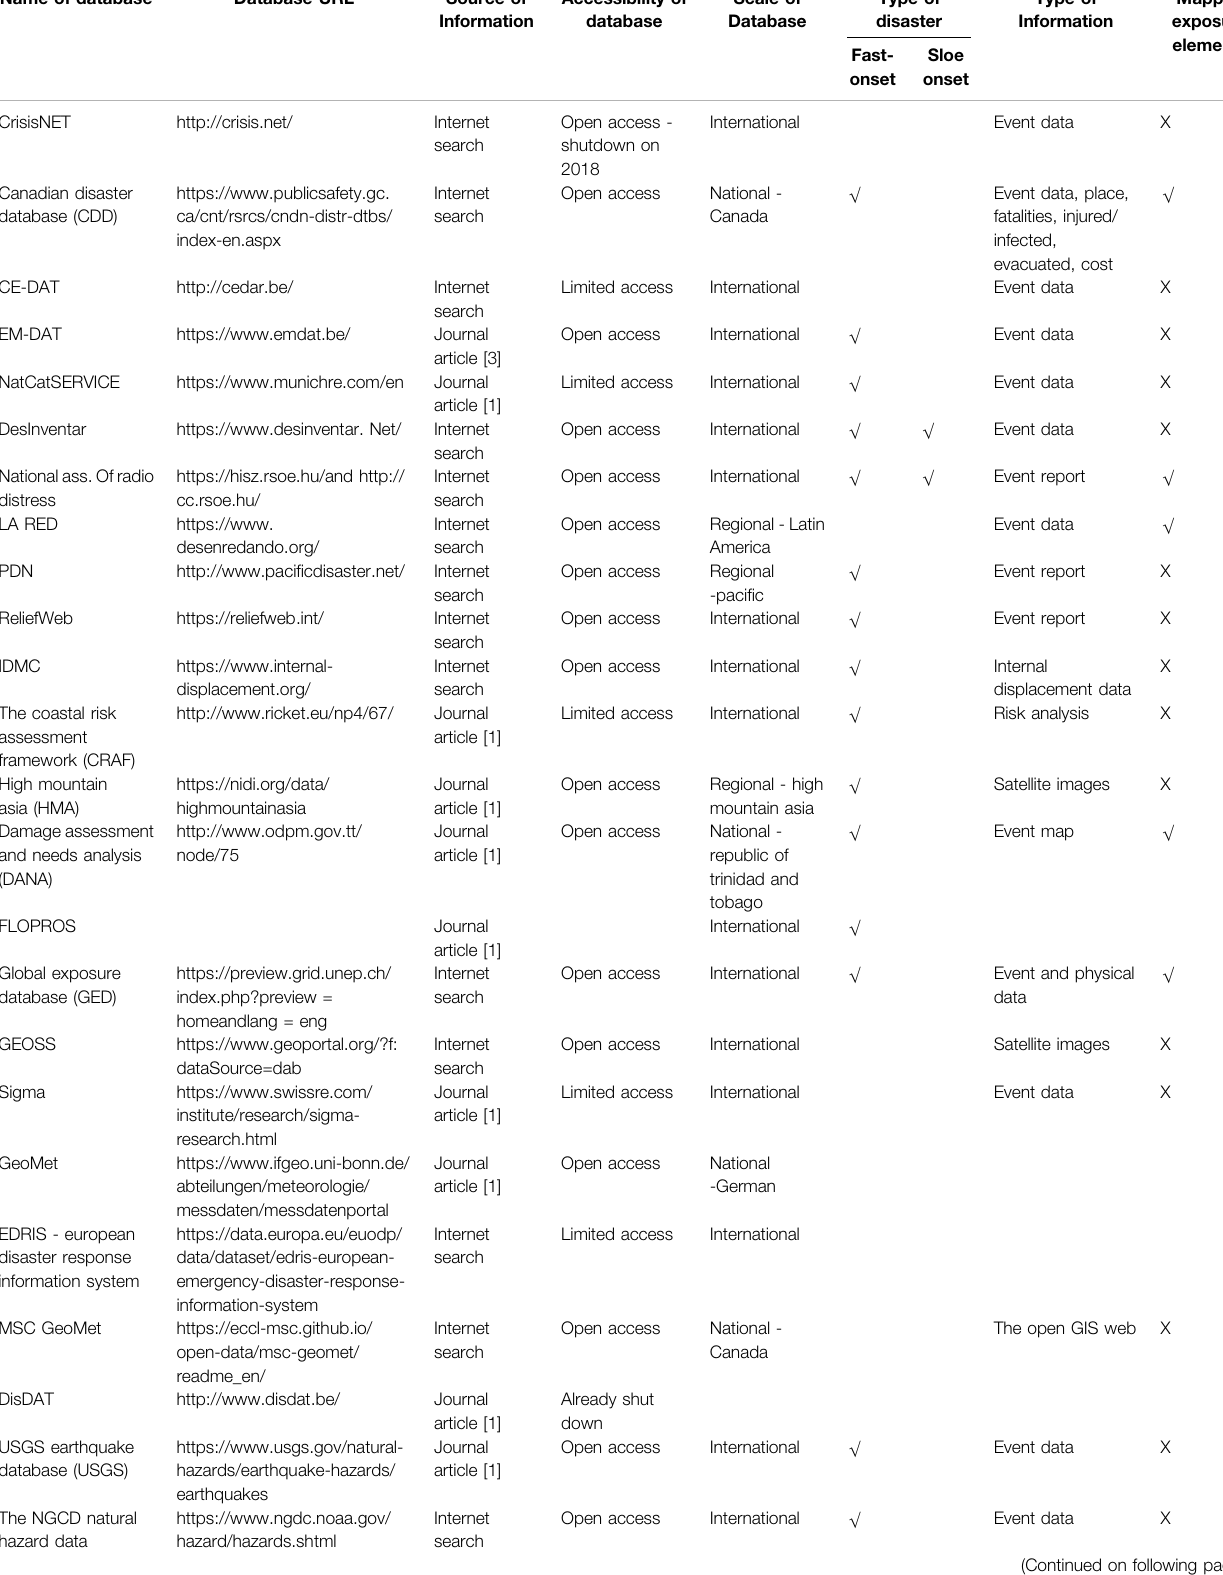
TABLE 2 | An overview of disaster related databases available on the internet (as of October